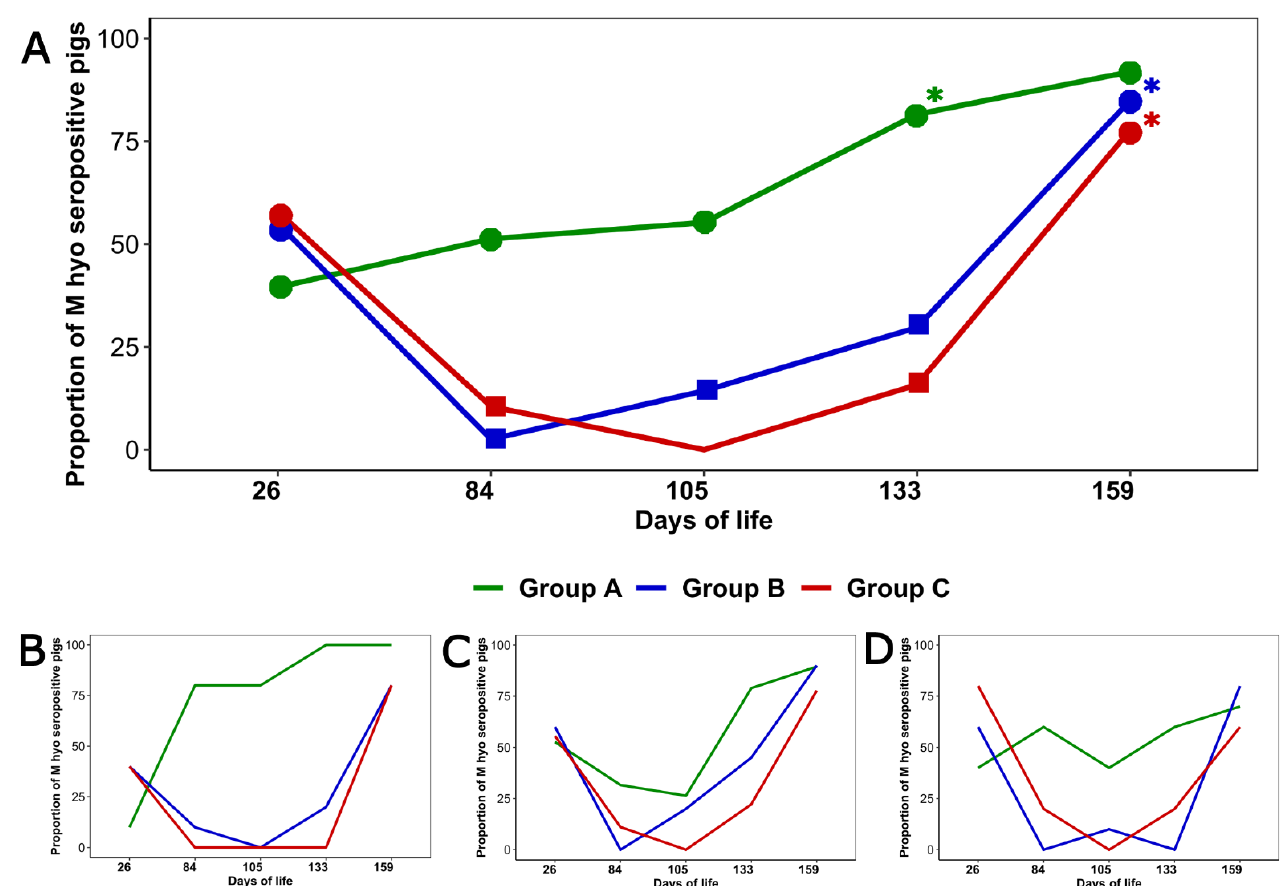
Figure 3. Dynamics of M. hyopneumoniae seropositivity. ( A ) shows the percentage of seropositive pigs to M. hyopneumoniae in each group. The different shapes indicate the significant differences in the percentage of M. hyopneumoniae seropositivity between the three groups at each sampling (at 105 days old all the piglets from Group C were seronegative). The asterisk (*) indicates the age at which a significant increase in the proportion of M. hyopneumoniae seropositivity was detected in each group. ( B – D ) represent the M. hyopneumoniae seropositivity in each group for pigs from 1st parity sows ( B ), 2nd to 4th parity sows ( C ) and ≥ 5 th parity sows ( D ).